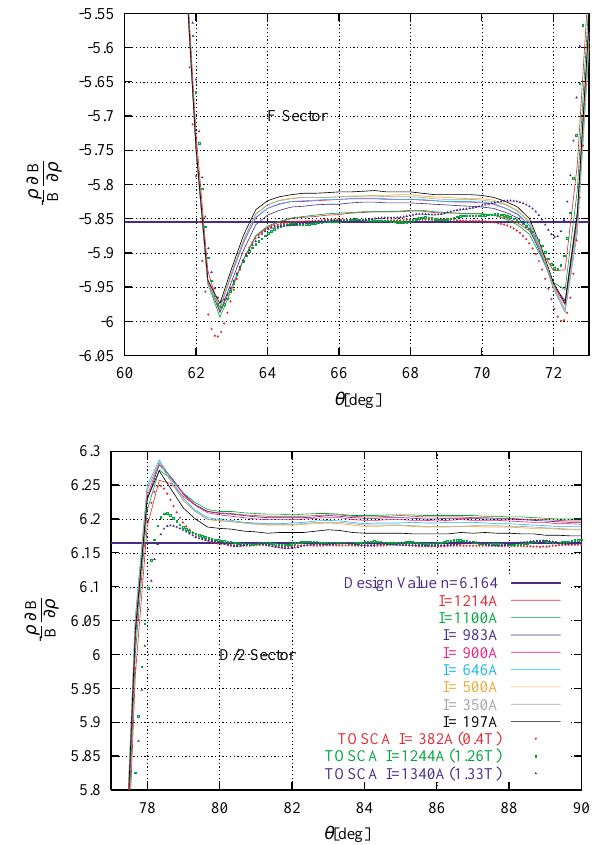
FIG. 14. (Color) n index